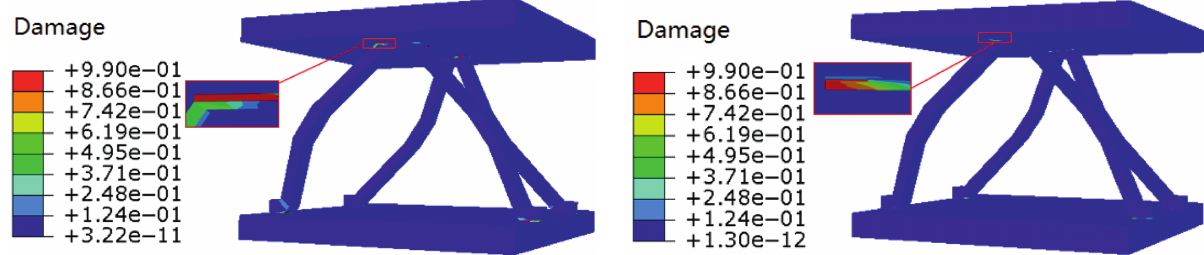
Figure 4: Damage contour at tensile load at 50,000 h.